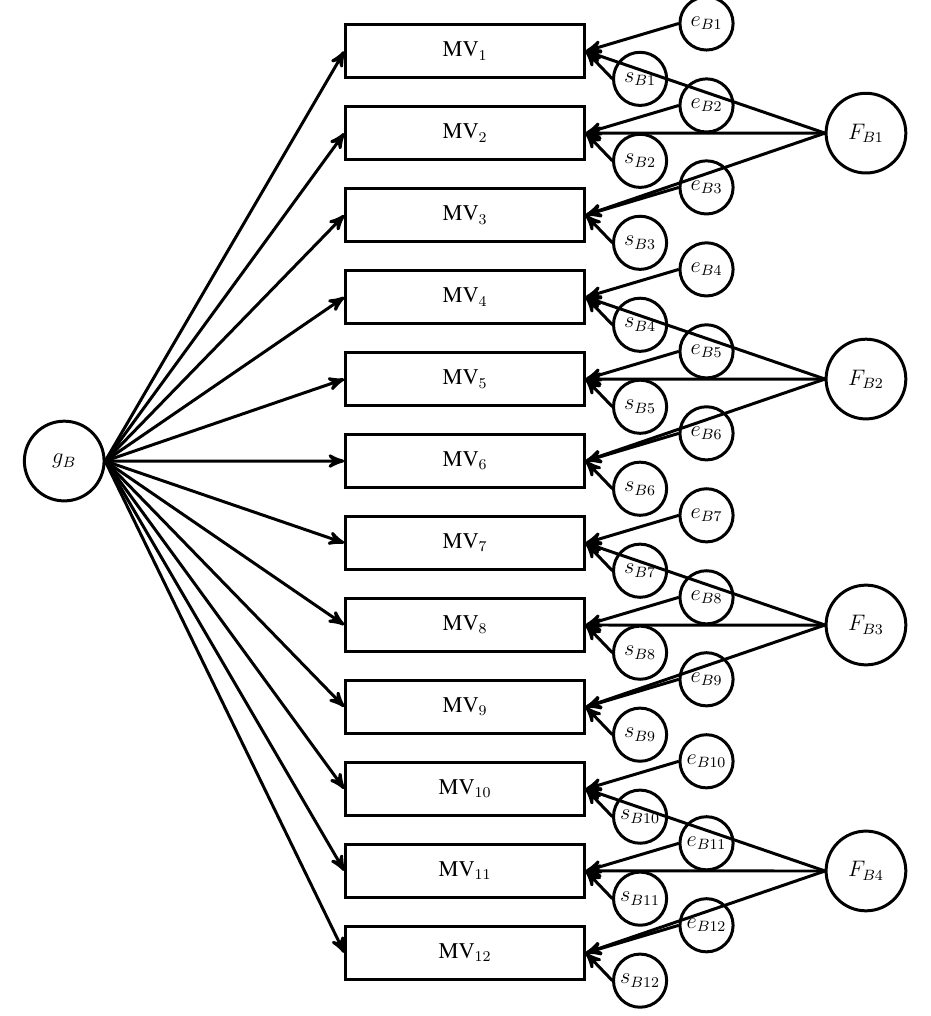
Figure 2. Example of a bi-factor model. MV: measured variable; F : group factors; s : specific factors; e :